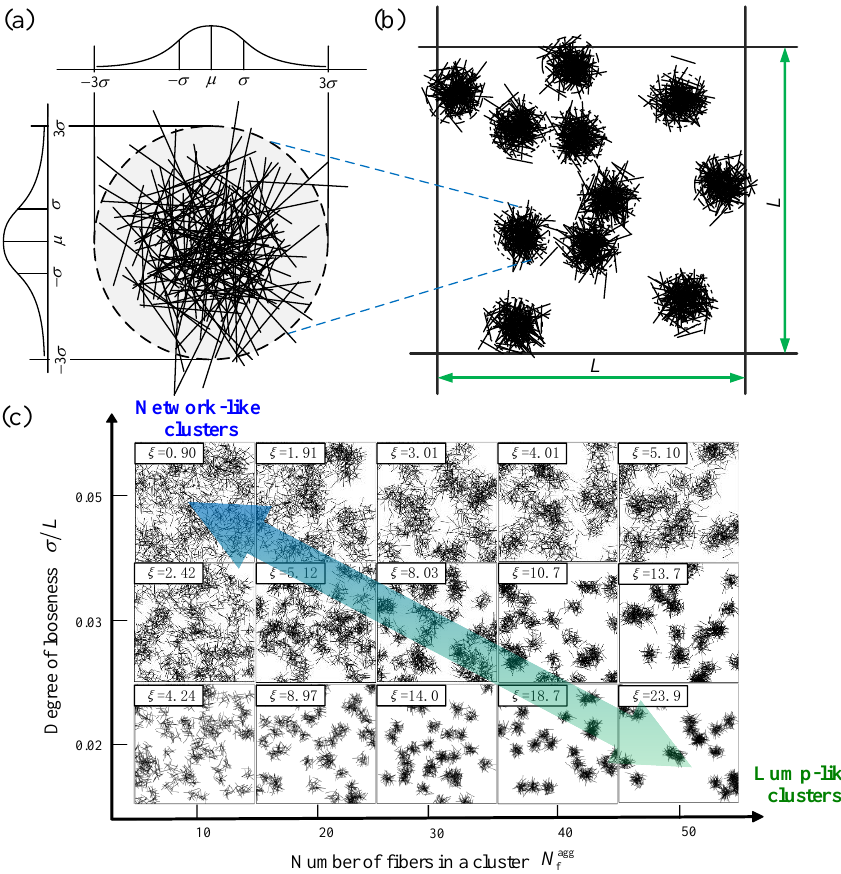
Figure 1. Schematic diagrams of ( a ) an aggregating cluster, ( b ) an RAE with multiple aggregating clusters, and ( c ) RAEs with different fiber dispersion states.